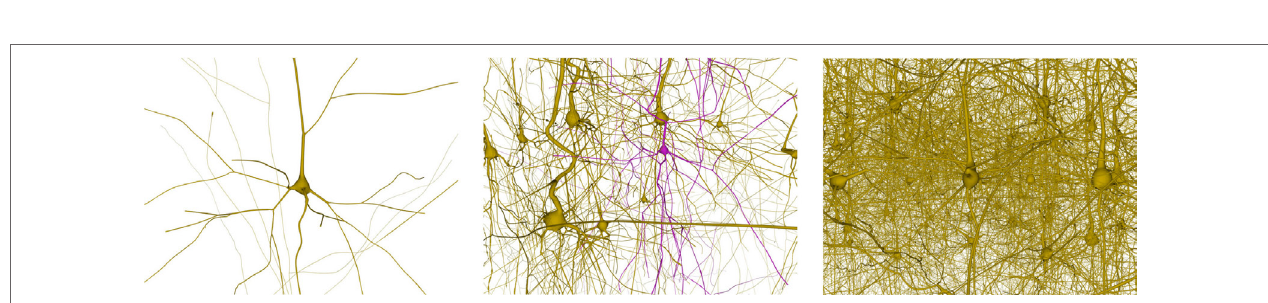
FIGURe 14 | Neuronal scenes used to evaluate the proposed method. Left image: a simple scene with just one neuron. Middle image: a scene with 10 different neurons showing one that has been selected. Right image: a more complex scene with one hundred